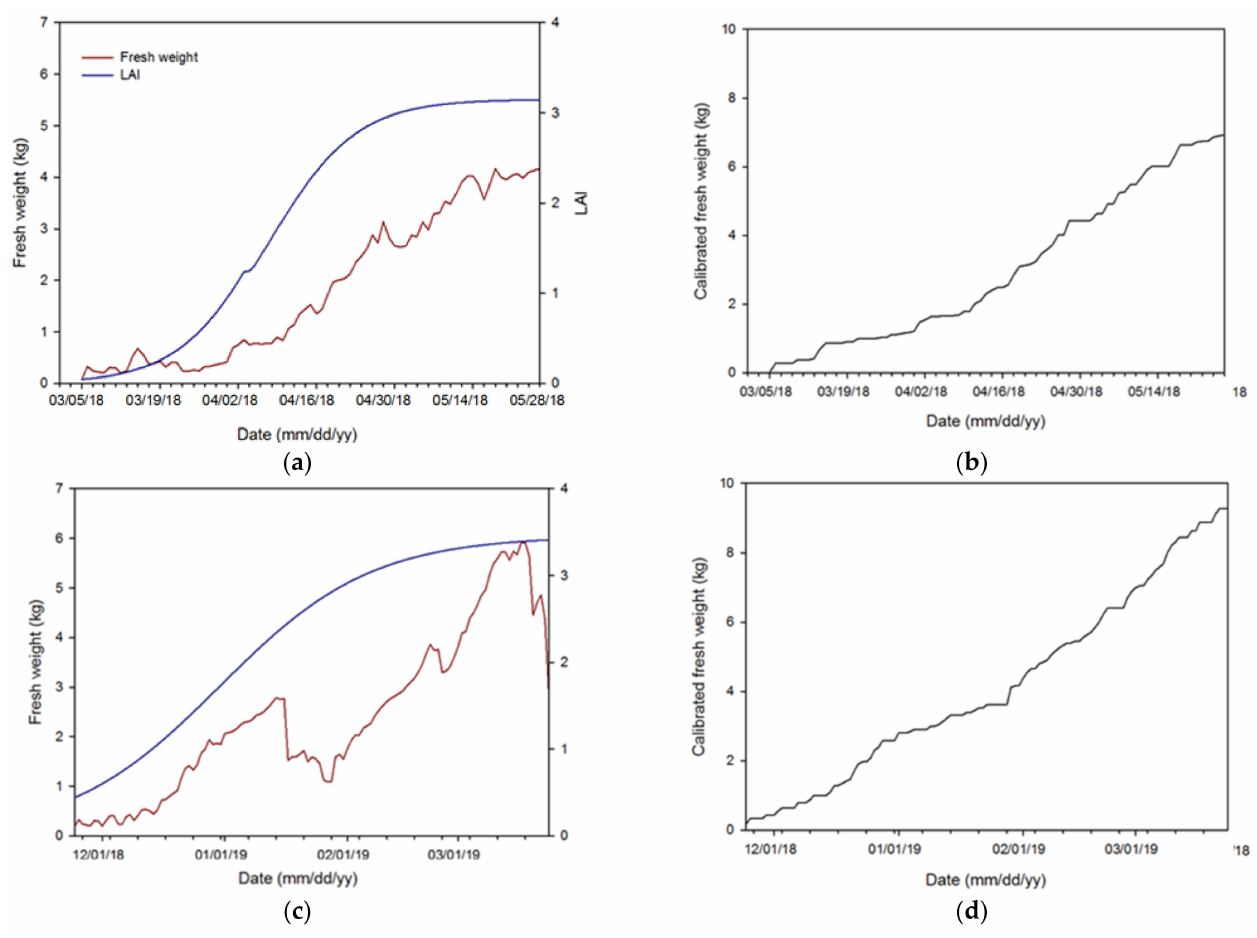
Figure 3. The weight of fruit yield and abortion at one-week intervals during growth period 1 (1 February 2018–1 June 2018) ( a ) and growth period 2 (1 December 2018–1 April 2019) ( b ).